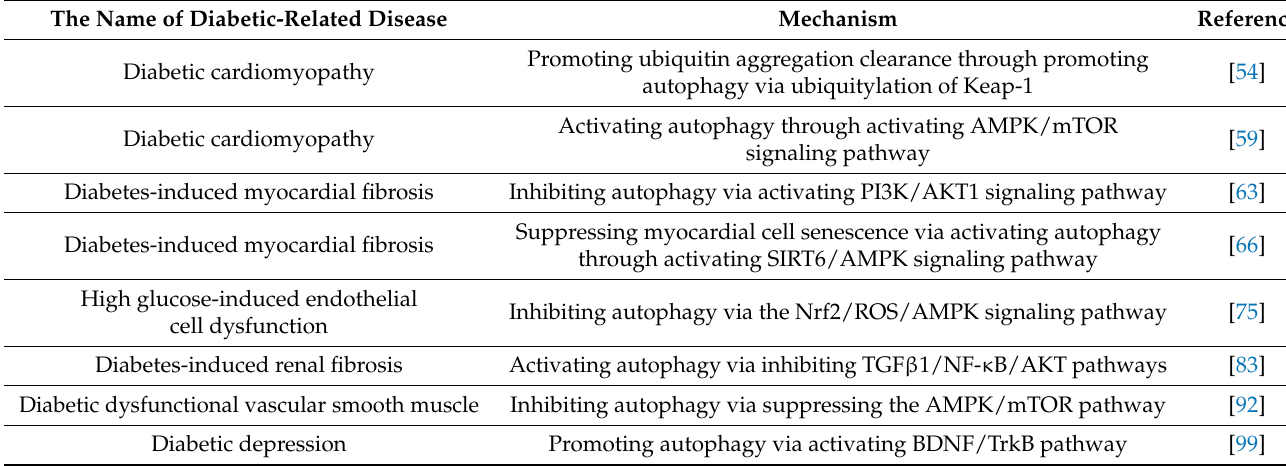
Table 1. The mechanisms of the roles of exogenous H 2 S regulating autophagy in diabetic-related